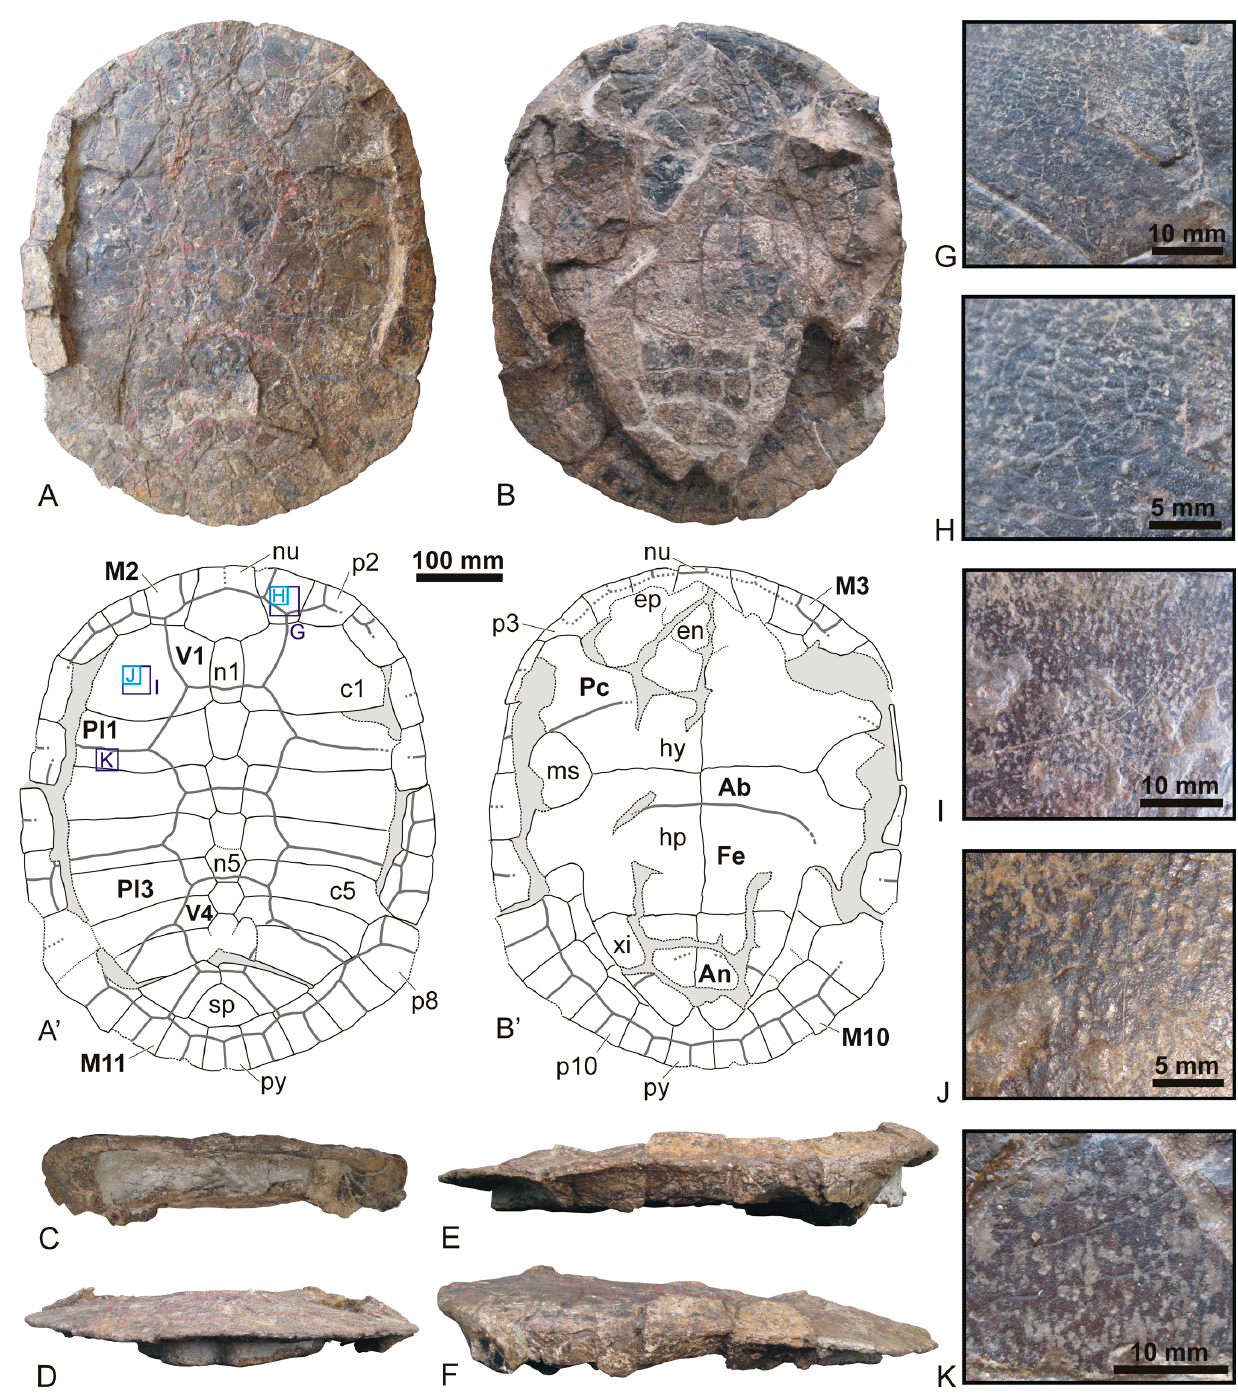
Figure 2. NHMUK R37356, shell corresponding to the holotype of the pleurodiran bothremydid turtle Abalakemys chapmanae gen. et sp. nov., from the upper Maastrichtian (Late Cretaceous) of